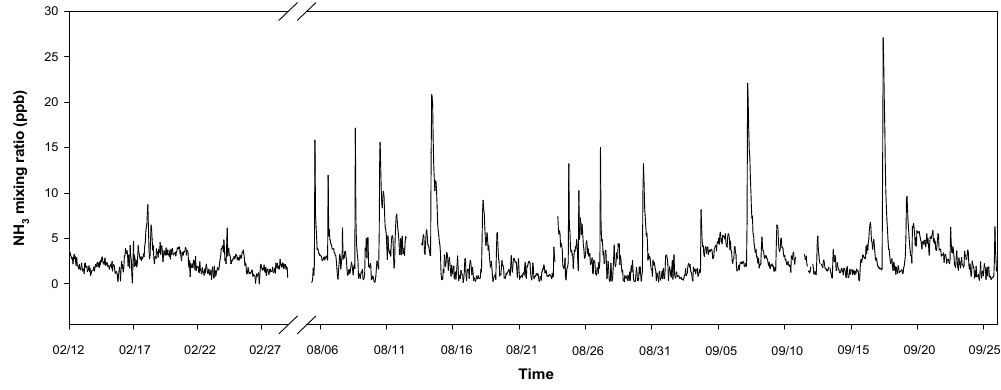
Fig. 2. A time series of NH 3 mixing ratios measured using an EC-QCL-based sensor atop the North Moody Tower in Houston, TX during the two sampling periods. Notable increases in the NH 3 mixing ratio are associated with transport from a coal-fired power plant, a chemical fire on an adjacent highway as a result of a crash of a tanker carrying agricultural chemicals, transport from the heavily industrialized HSC, and transport from the Gulf of Mexico during Hurricane Hermine.